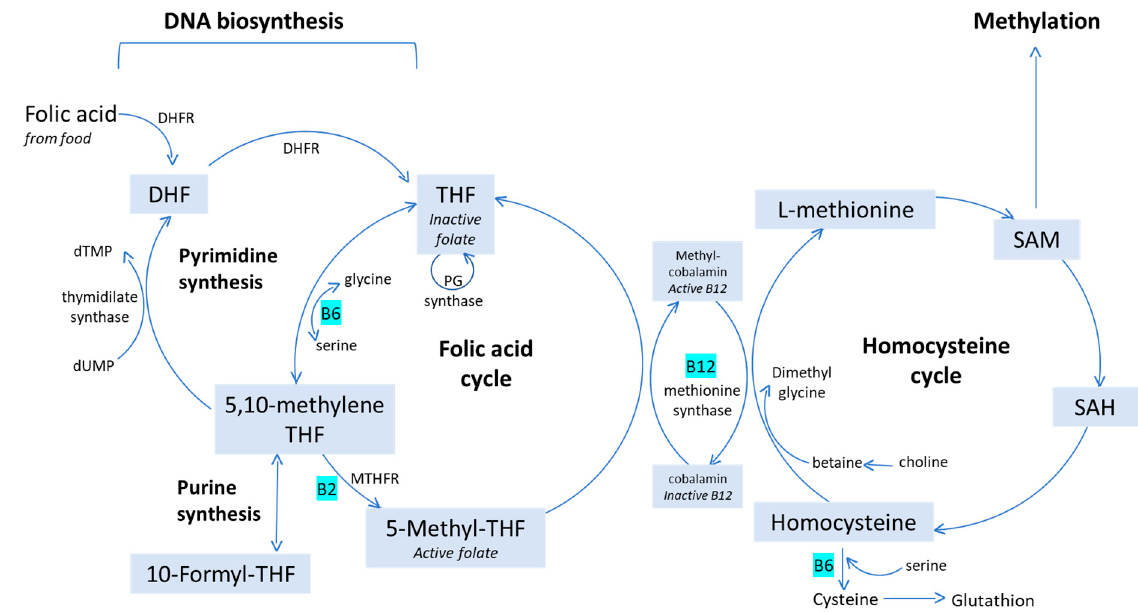
Figure 1. Folate-mediated metabolism and connection with homocysteine cycle.